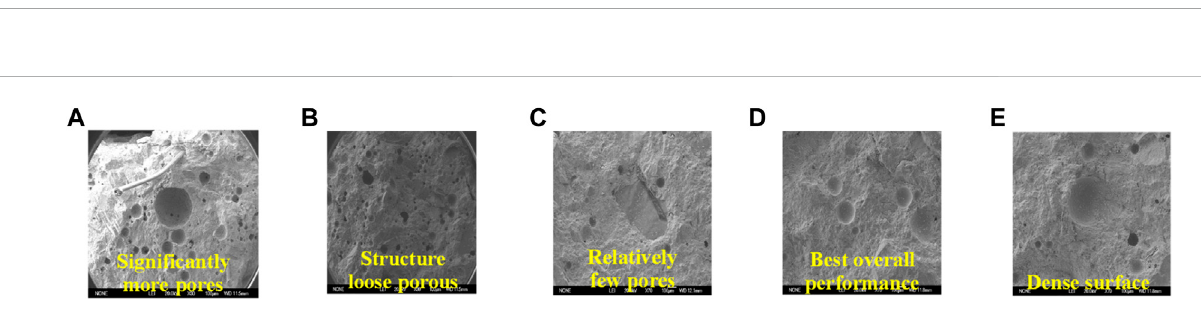
FIGURE 3 Porestatusofthematerialafter240 doferosion(30×). (A) InternalporeimageofS1specimens. (B) InternalporeimageofS2specimens. (C) Internal pore image of S3 specimens. (D) Internal pore image of S4 specimens. (E) Internal pore image of S5